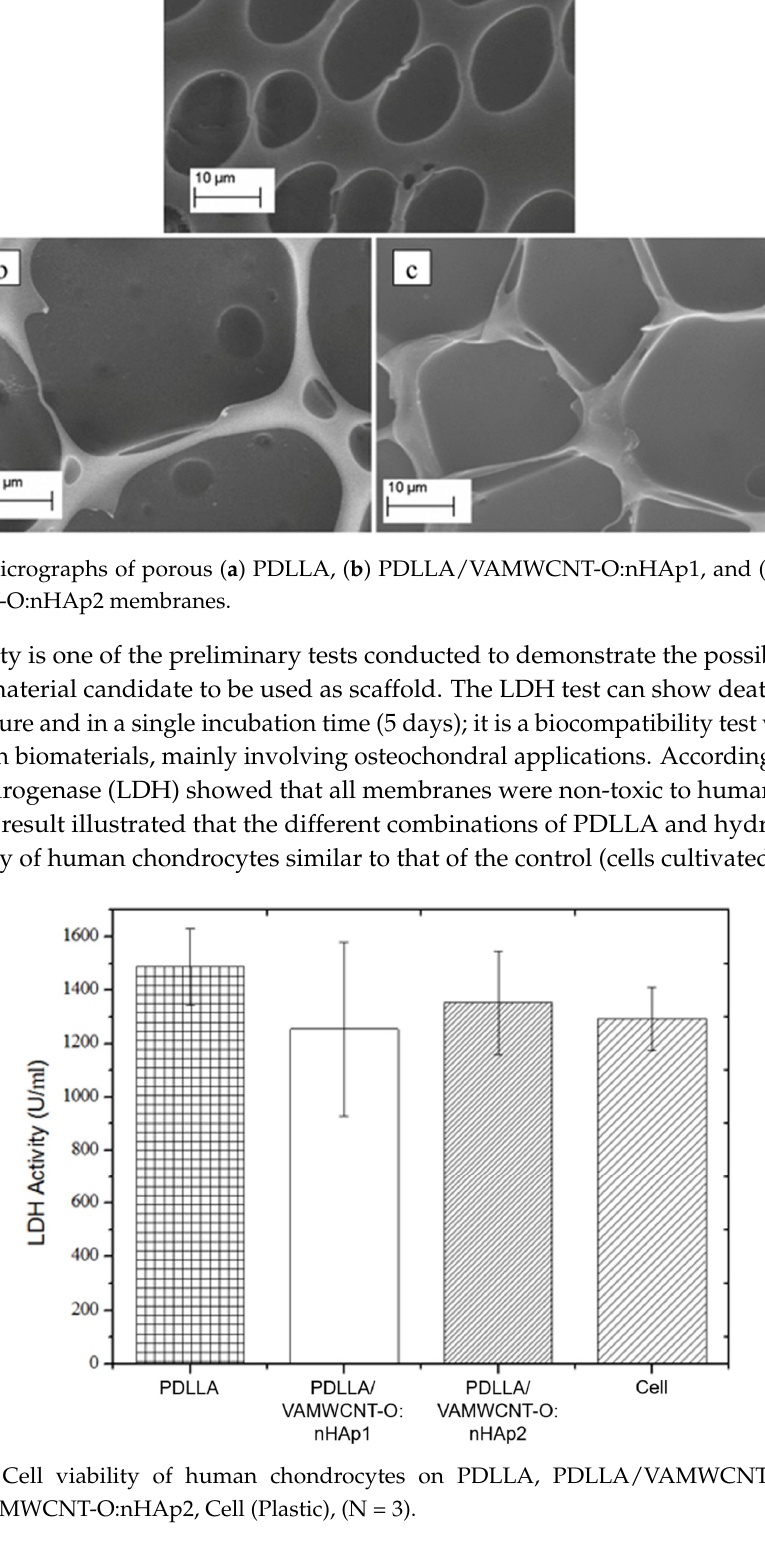
Figure 2. Cell viability of human chondrocytes on PDLLA, PDLLA/VAMWCNT-O:nHAp1, PDLLA/VAMWCNT-O:nHAp2, Cell (Plastic), (N = 3).